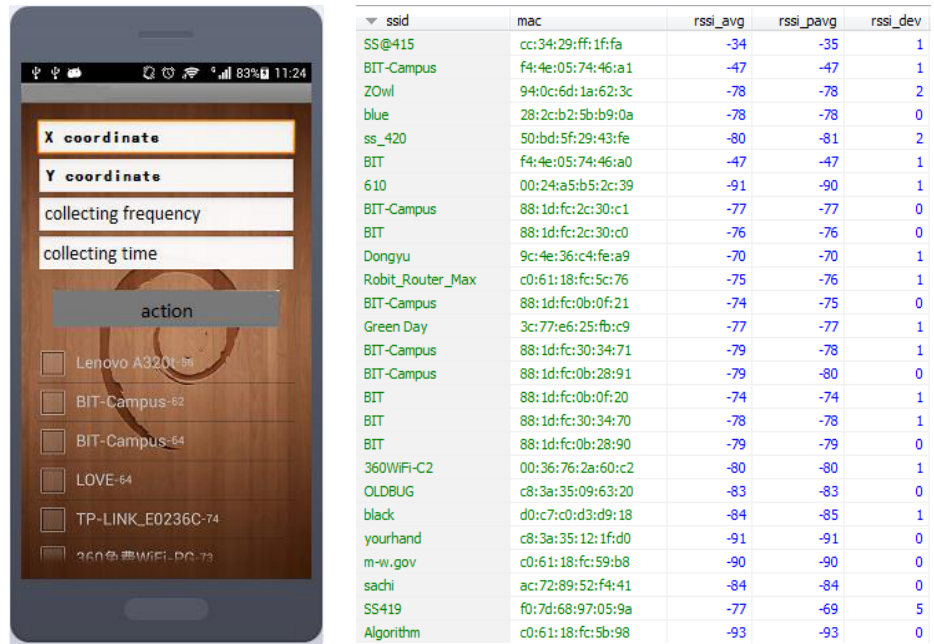
Figure 5. The mobile client and one fingerprint.